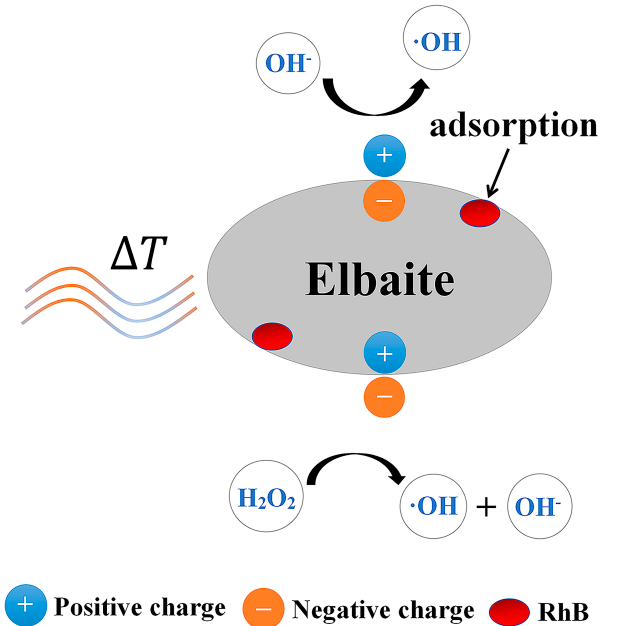
Figure 6. Devised mechanism for RhB degradation in the elbaite/H 2 O 2 system.